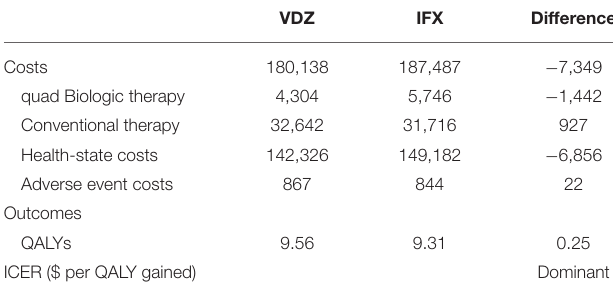
TABLE 2 | Model inputs for costs and health utility. TABLE 3 | Base-case analysis